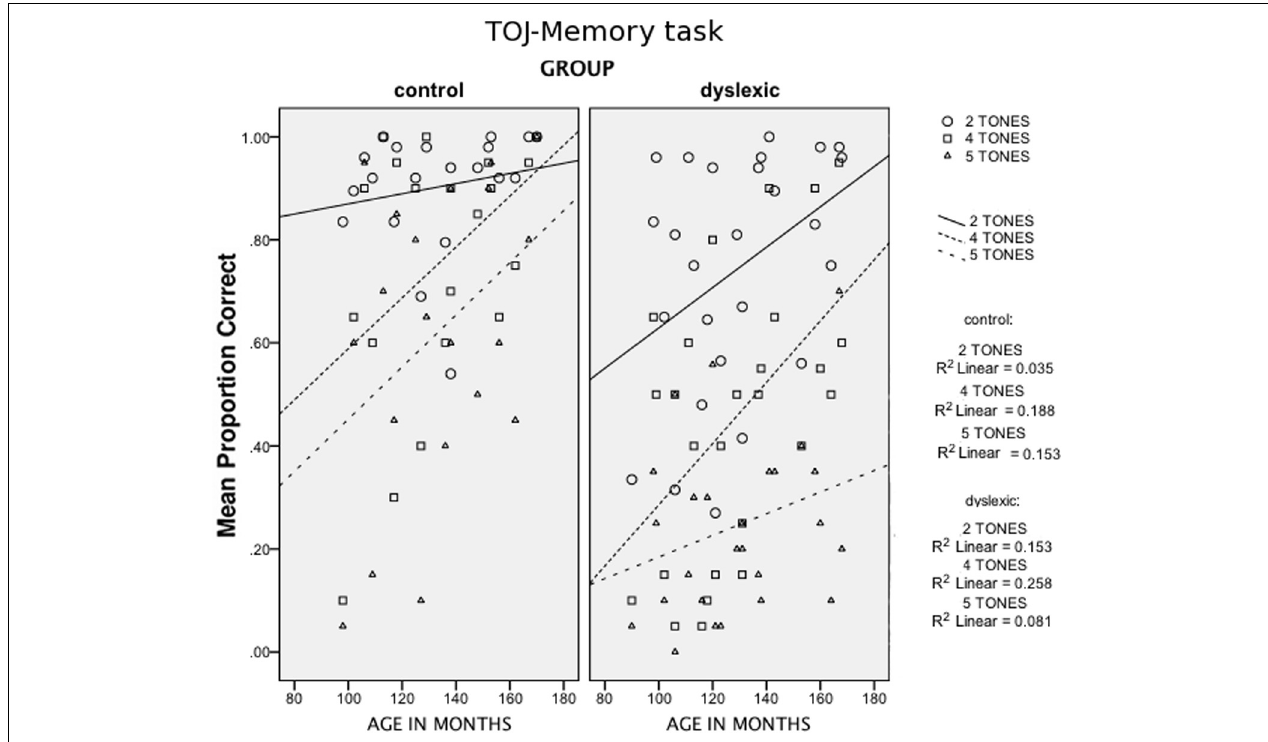
FIGURE 2 | Scatter plots of Age (in months, x-axis) against the mean proportion of correct answers in the TOJ-Memory task (y-axis), for the different Sequence Length conditions (2, 4, and 5-tone conditions) for the two groups (control children and children with DD).